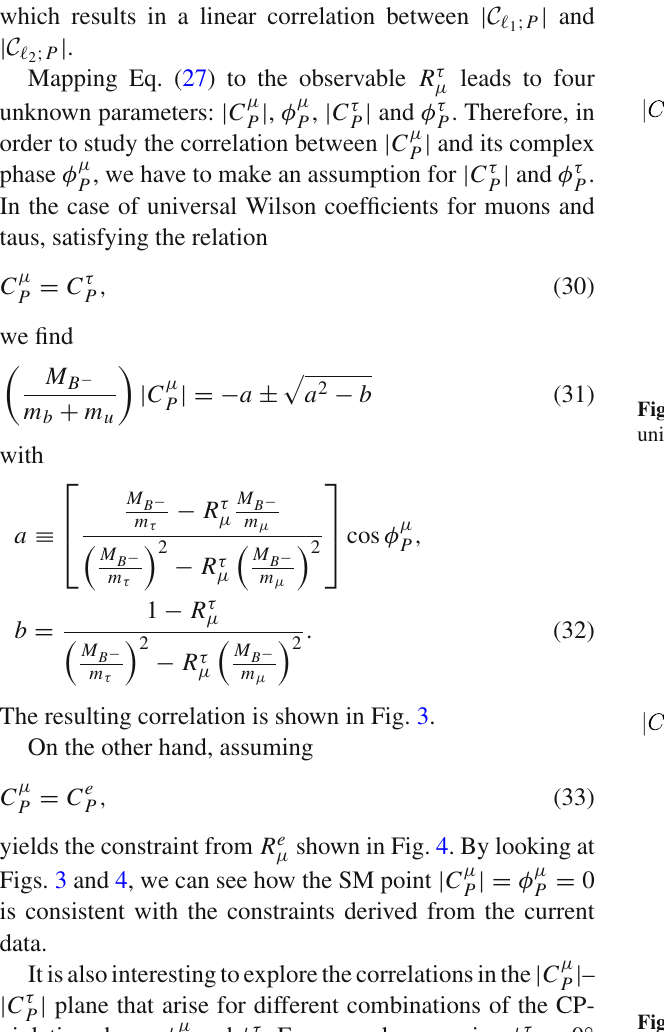
Fig. 4 New physics regions in the φ